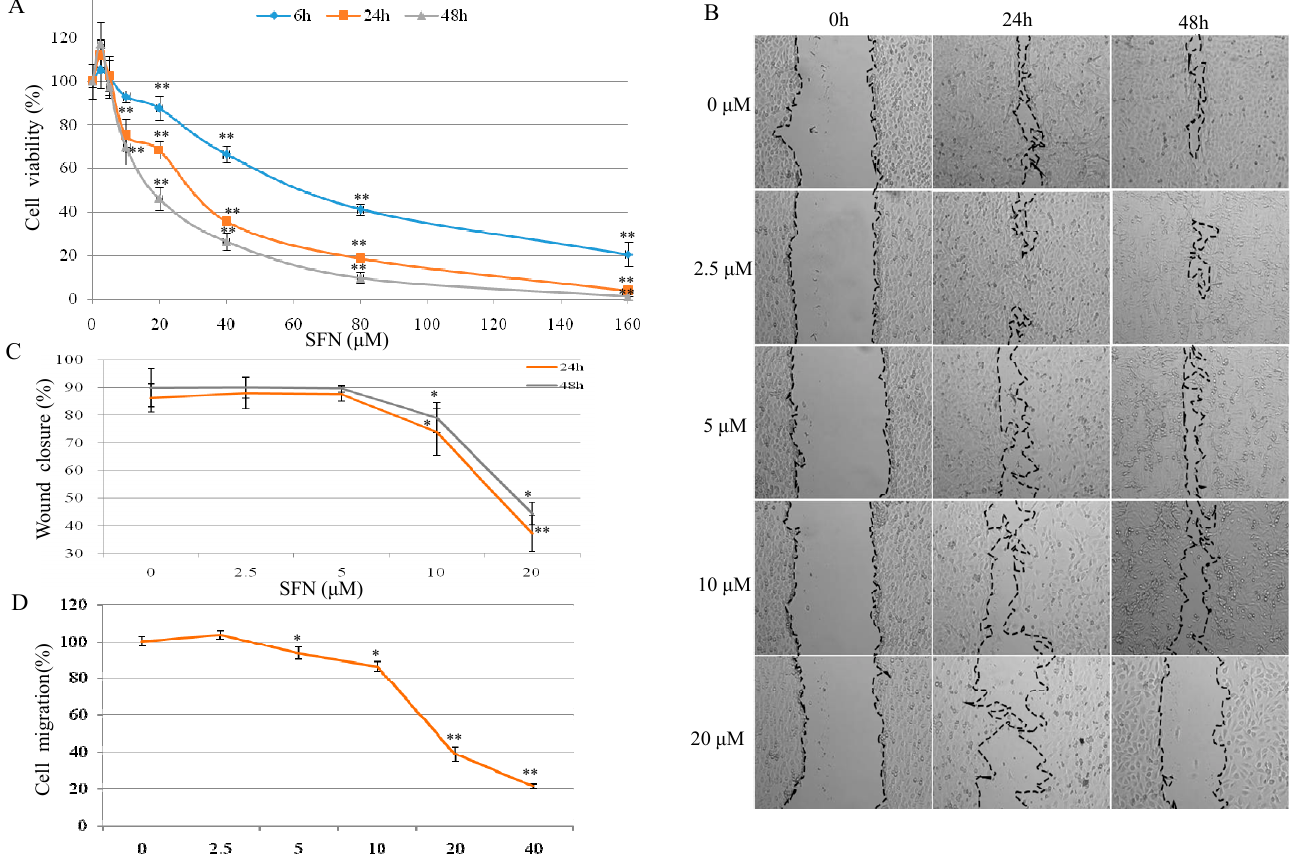
Figure 1. Effects of SFN on cell viability and cell migration in T24 cells. ( A ) T24 cell viability was determined by MTT cell proliferation assay. T24 cells were treated with serial concentrations of SFN (2.5–160 µM) for 6, 24, and 48 h. Each data point represents the mean ± standard deviation (SD) of three experiments, and each treatment was performed in six replicates. ( B ) Scratch assay. A plastic tip was used to scratch a clean wide wound area. Cells were then incubated with SFN for 24 and 48 h. Migration areas were photographed (×100) and calculated with Image J software ( C ). ( D ) Effects of SFN on cell migration. After starvation overnight, T24 cells were treated with SFN (0–40 µM) for 24 h. Cell migration was measured by cell migration assay. Results were compared to control. All data represent the mean ± SD of three experiments, each treatment in six replicates. Statistical significance versus control: * P < 0.05, ** P < 0.01.